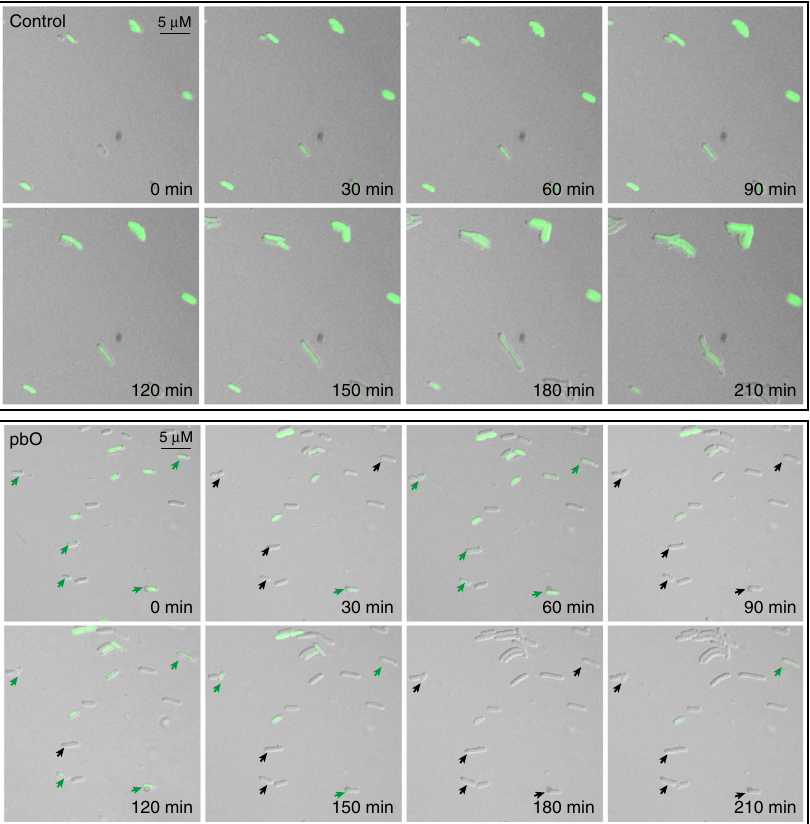
Fig. 4 The single-cell fl uorescence microscopy of the control and pbO system. Engineered cells were immobilized on LB agar on a microscope slide, and imaged every 30 min using microscope. Green arrows indicate the formation of fl uorescence, whereas black arrows indicate the loss of fl uorescence. Compared with the control strains, the arrow-marked pbO cells can exhibit periodic fl uorescence loss and revival as time progresses. The reason for the loss of fl uorescence after 150 min could be explained by oxygen de fi cit. Under the anaerobic microenvironment, the newly synthesized fl uorescence protein is dif fi cult to be oxidized to mature. Source data are provided in Source Data fi